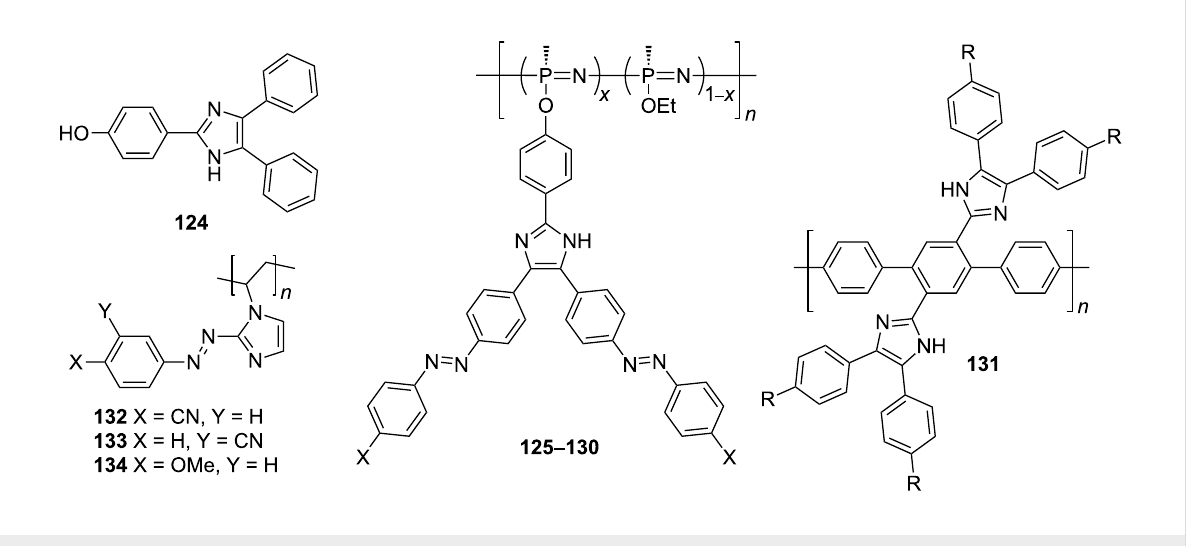
Figure 22: Structure of polyphosphazene polymers bearing NLO-phores [125-127] and some other recent examples of nonlinear optical polymers [19,128].